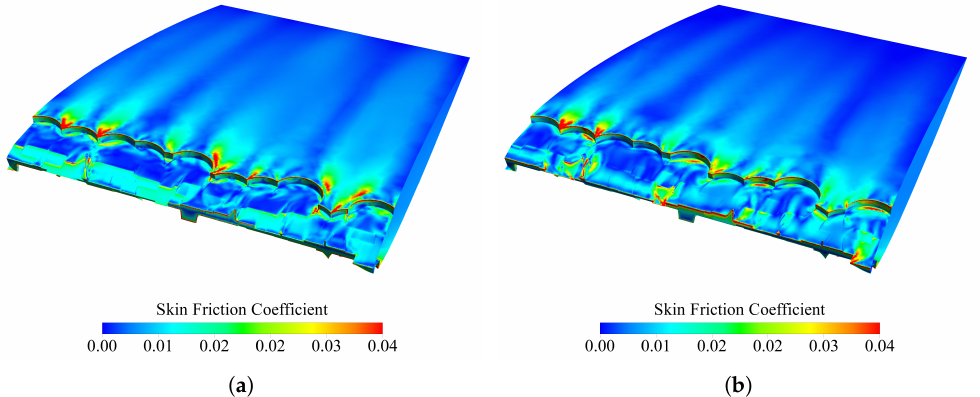
Figure 12. Comparison between contour plots of the friction coefficient on the damaged blade at 0 ◦ incidence and 4 ◦ incidence. ( a ) C f contour at α = 0 ◦ ; ( b ) C f contour at α = 4 ◦